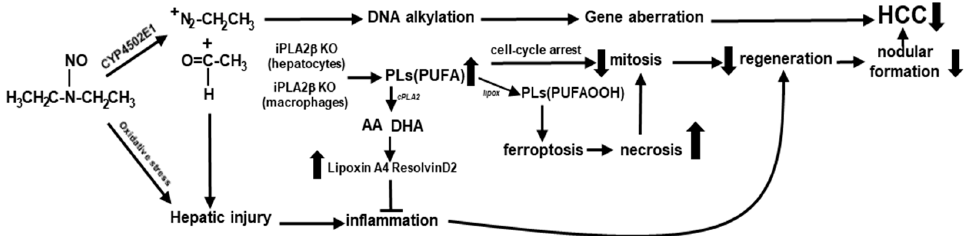
Figure 4. iPLA2 β deficiency in hepatocytes results in an increase in hepatic PUFA-containing PLs leading to an induction of a cell-cycle arrest, suppression of HCC regenerative response, and induction of hepatic necrosis and ferroptosis likely via lipoxygenase-induced oxidation of PLs [PLs(PUFAOOH)]. Similarly, iPLA2 β deficiency in macrophages may lead to ferroptosis. As a background, ferroptosis may lead to hepatic necrosis which may limit mitosis and liver cell regeneration. PLs(PUFA) are also precursors of pro-resolution lipoxin A4 and resolvinD2 leading to an attenuated inflammatory response resulting in reduced liver cell regeneration, reduced nodular formation, and HCC